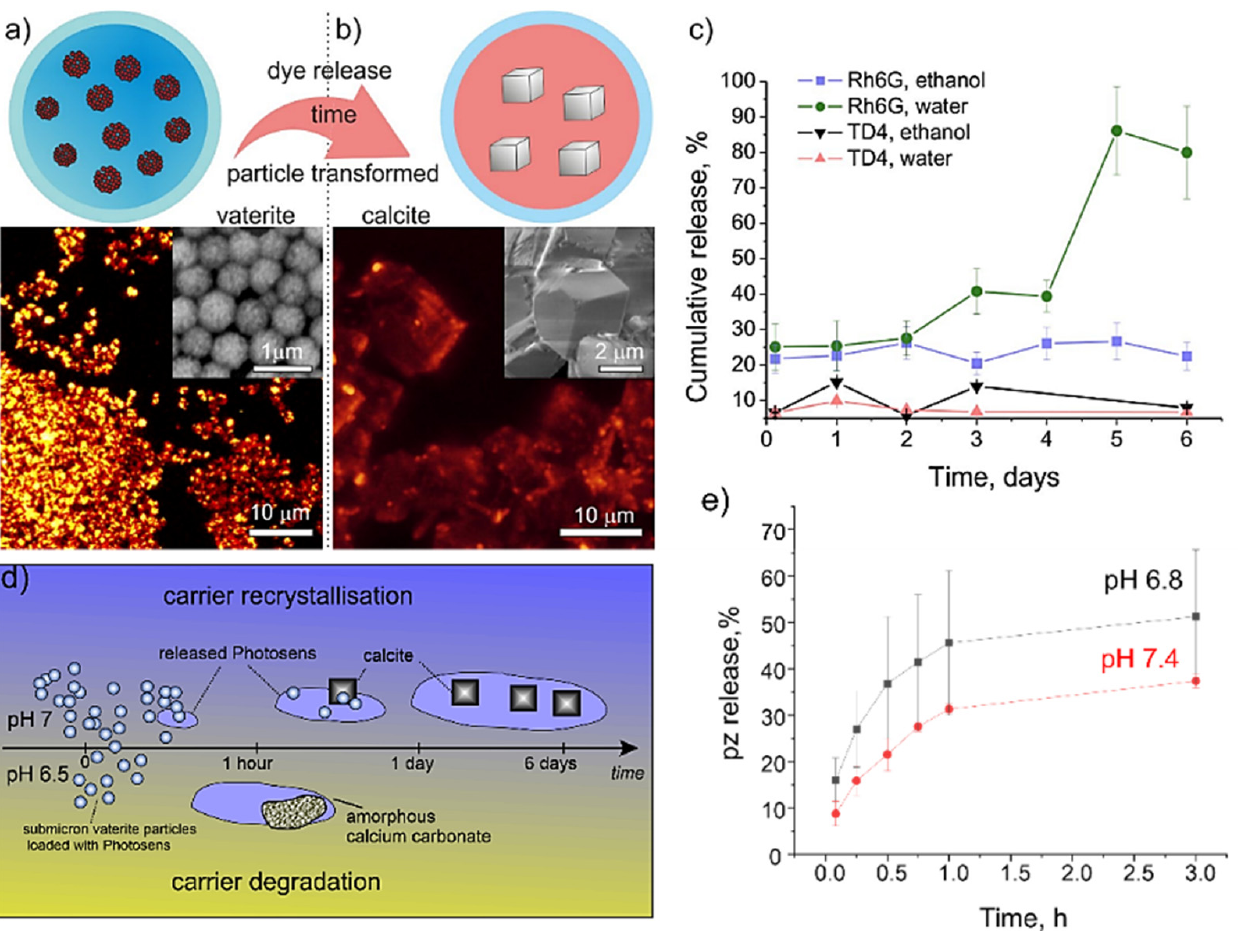
Figure 5. Capsule recrystallization in a medium. Panels ( a , b ) represent a scheme of the release mechanism and the corresponding container two-photon microscope fluorescence images with scanning electron microscopy (SEM) images as insets. ( a ) The carriers are in a pure vaterite phase with all dye encapsulated; panel ( b ) shows the calcite phase, where the dye was released into the medium apart from residuals attached to the crystal surfaces. Panel ( c ) displays dye release curves for different payloads measured by spectrofluorometry during the immersion in water and in ethanol. Panels ( a – c ) are reproduced with permission from [70], the Royal Society of Chemistry, 2013; panel ( d ) schematics of the degradation of particles due to pH changes. Reproduced with permission from [73], Elsevier, 2013. Panel ( e ) depicts release of the perphenazine. Reproduced with permission from [74], Elsevier, 2021.